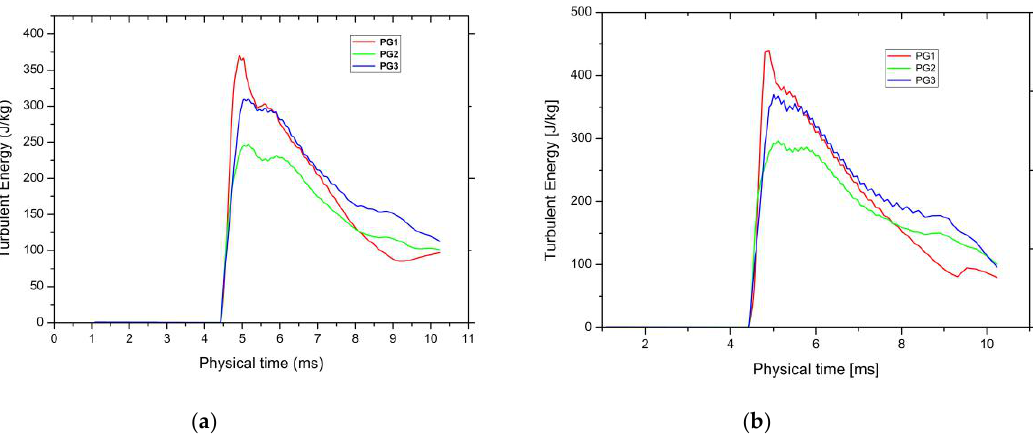
Figure 11. ( a ) Unsteady in-cylinder turbulent energy for pure CNG; ( b ) Unsteady in-cylinder turbulent energy for H 2 CNG30.